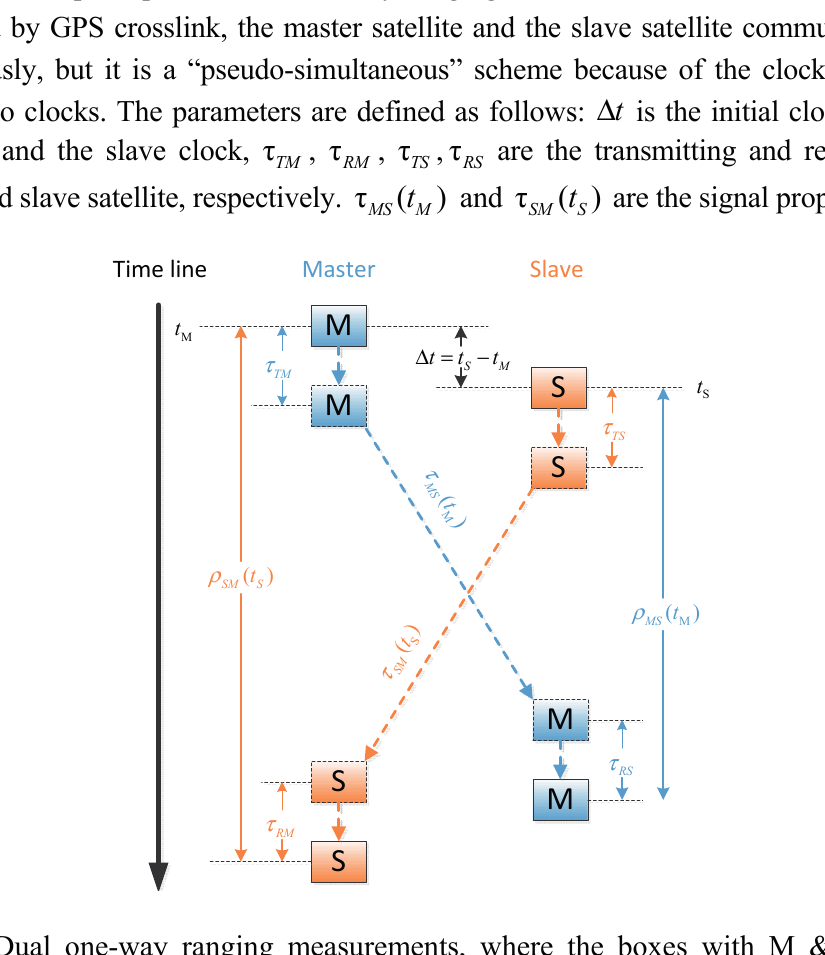
Figure 4. Dual one-way ranging measurements, where the boxes with M & S denote master and slave